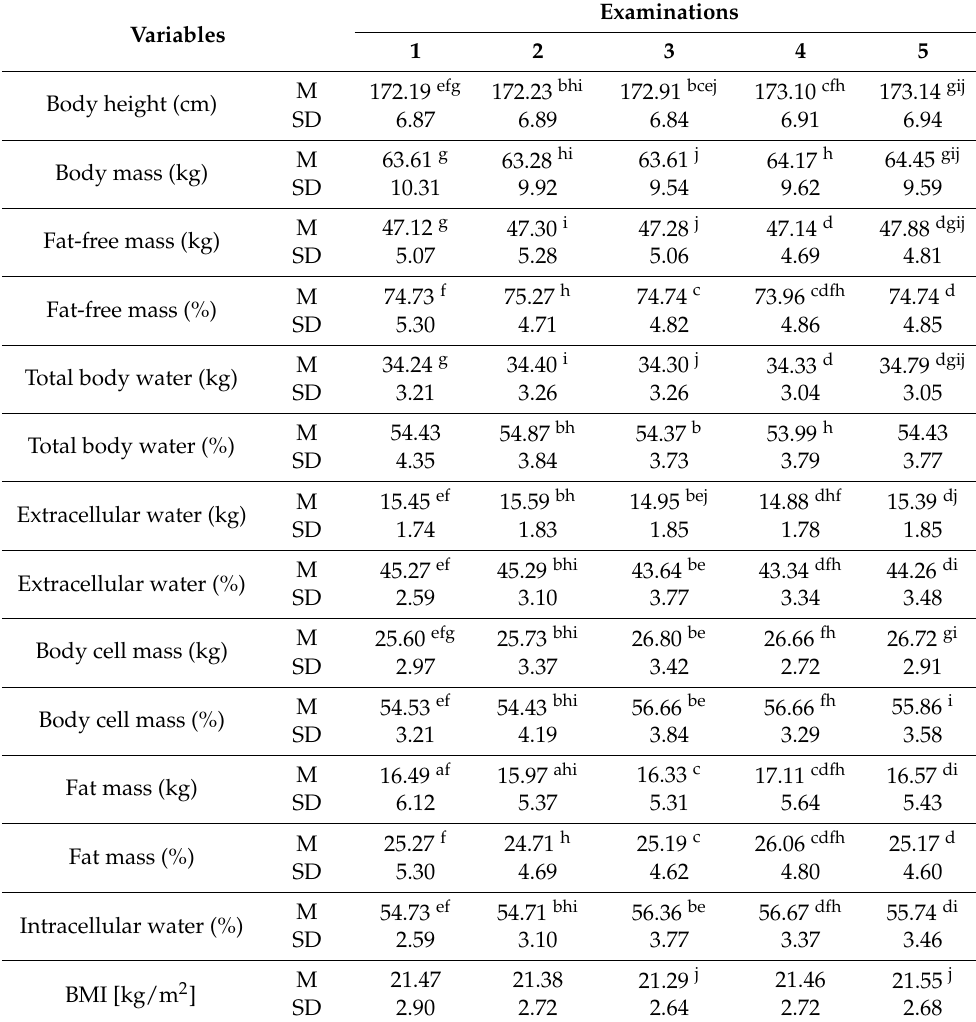
Table 1. Statistical characteristics of the basic somatic features and body composition of female volleyball players in subsequent periods of the